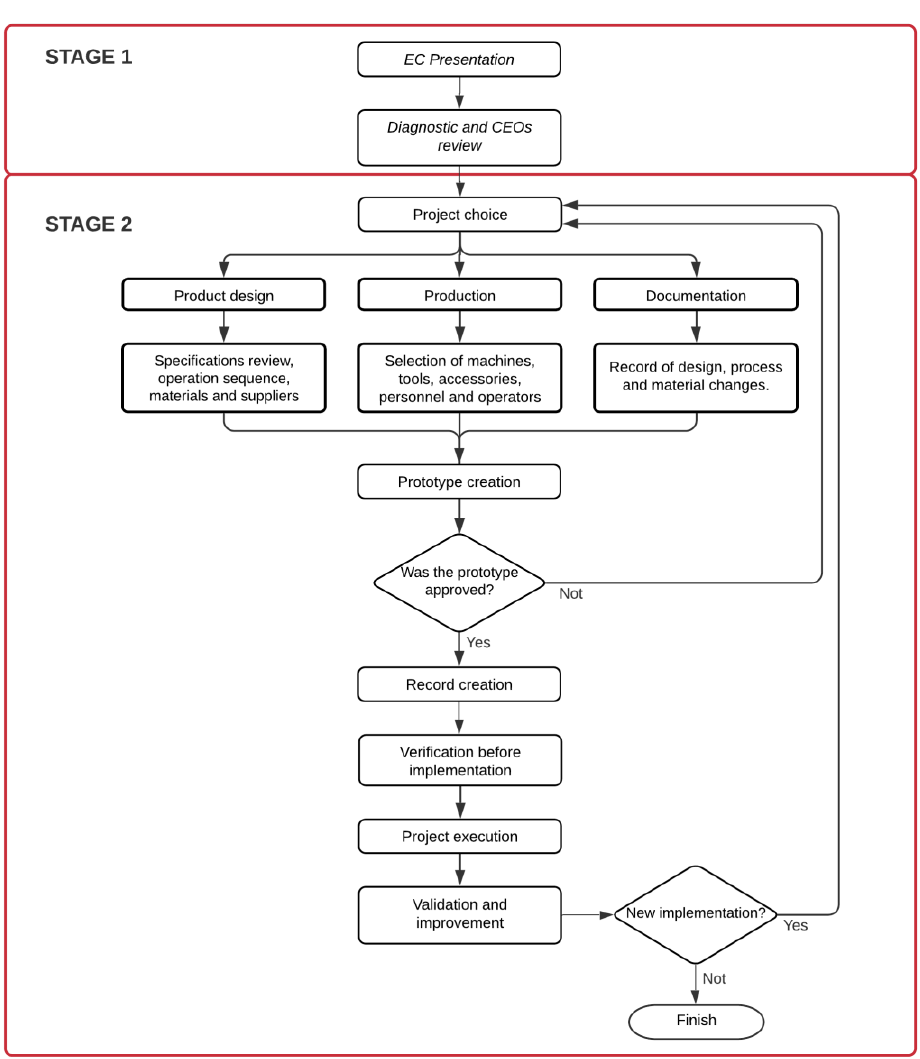
Figure 1. The proposed model DINP (Development and Implementation of New Products).